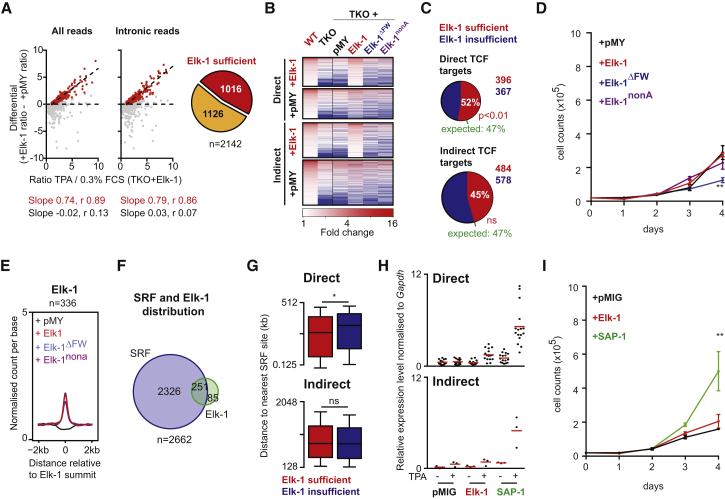
Elk-1 Acts with SRF to Restore TCF-Dependent Gene Expression in TKO MEFs(A) Identification of genes whose induction in TKO MEFs is restored by expression of wild-type human Elk-1. The plots compare the TPA induction ratio in TKO MEFs with and without Elk-1 expression for both total and intronic RNA-seq reads. Genes whose induction is restored by Elk-1 (red) exhibit a systematic relationship between their inducibility in the two contexts whereas others (gray) do not; slope and Spearman r are indicated. Right: summary.(B) Heatmap representation of TPA-induced gene expression (fold change over baseline) in wild-type and TKO MEFs and TKO MEFs expressing the indicated Elk-1 derivatives. Genes whose regulation is restored by wild-type Elk-1 are shown, divided into Direct and Indirect categories. The plot is ranked by the magnitude of the TPA-induced changes in wild-type MEFs.(C) Proportions of Direct and Indirect TCF target genes whose regulation by TPA is restored by Elk-1 expression. Restoration of Direct, but not Indirect, targets is significantly above the 47% expected from the overall restoration of TCF targets (two-tailed binomial test, ∗p < 0.05).(D) Expression of human does not restore the proliferation defect observed in TKO MEFs. Cell counts for TKO MEFs expressing the indicated proteins were recorded over 4 days.(E) Metaprofiles showing the average normalized count per base across the 336 Elk-1 binding sites identified by ChIP-seq in TKO MEFs reconstituted with Elk-1 derivatives as indicated.(F) Coincidence between SRF and Elk-1 ChIP-seq peaks.(G) Direct TCF-SRF targets whose regulation is restored by Elk-1 expression are closer to SRF sites than those whose regulation is not. Mann-Whitney test, ∗p < 0.05.(H) Elk-1 transactivation is weaker than that of SAP-1. TPA induction of 16 direct TCF targets (Egr1, Egr2, Egr3, Ier2, Per1, Junb, Fos, Zfp36, Dnajb1, Arl5, Pitpna, Mob3a, Pramef8, Tada3, Argap1, and Arpc4) and three indirect targets (Ier3, Klf10, and Cxcl1) was analyzed by qRT-PCR.(I) SAP-1 expression restores proliferation in TKO MEFs. Cells were counted over 4 days. Two-way ANOVA, ∗∗p < 0.01.See also Figure S4 and Tables S5 and S6.